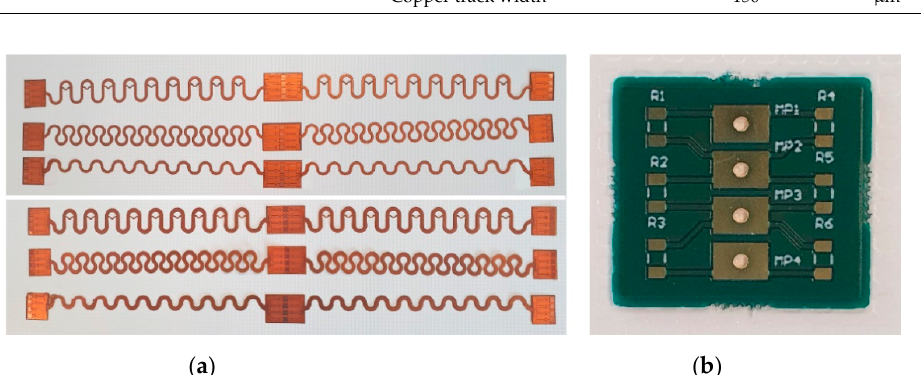
Figure 3. ( a ) Different meander designs. From the top: Meander type 1, type 2 and type 3 and Meander type 1-1, 2-2 and 3-3. ( b ): Dummy PCB (printed circuit board) that was soldered to the central interposer.